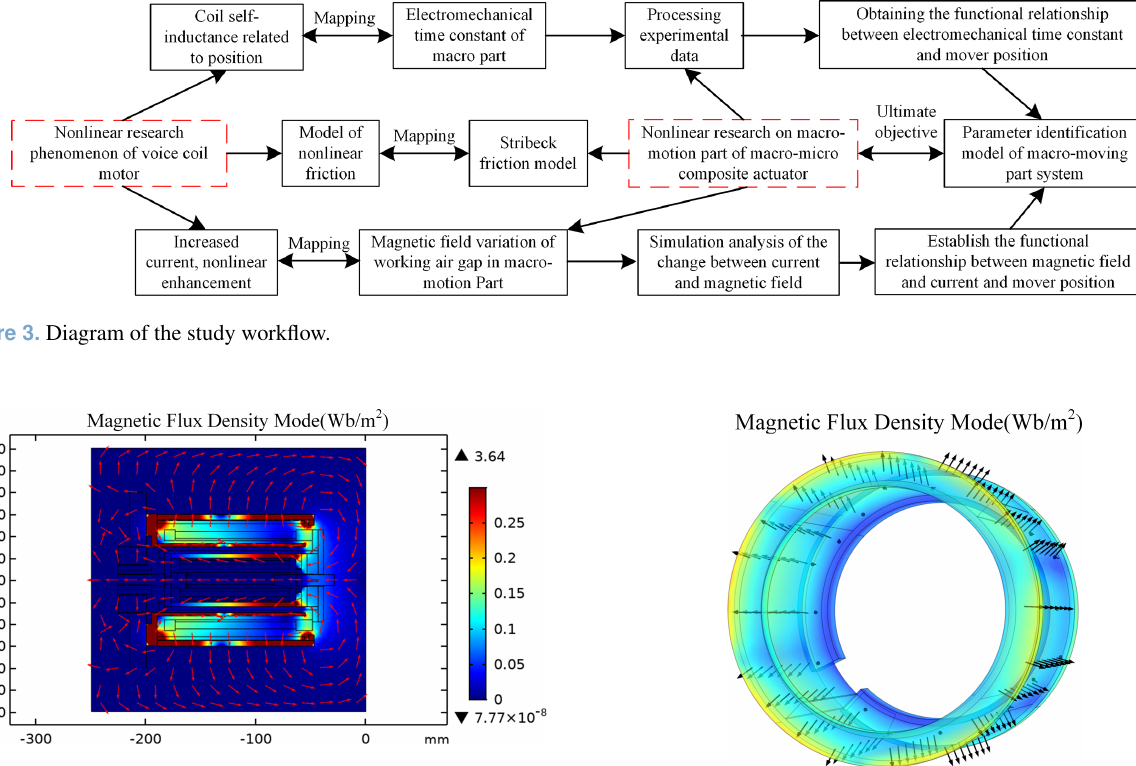
Figure 4. Magnetic field distribution of macro-motion part of the macro–micro composite actuator.